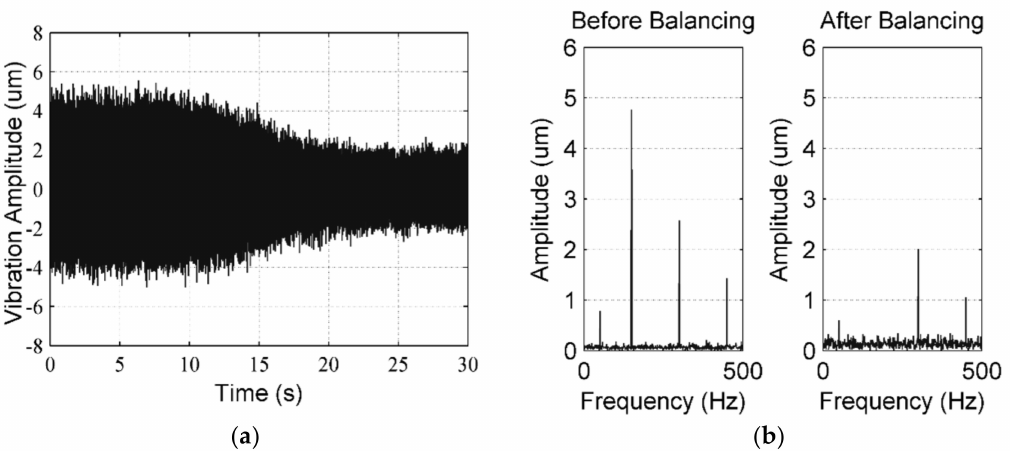
Figure 11. Balancing results at 9000 rpm: ( a ) overall vibration amplitude; and ( b ) FFT